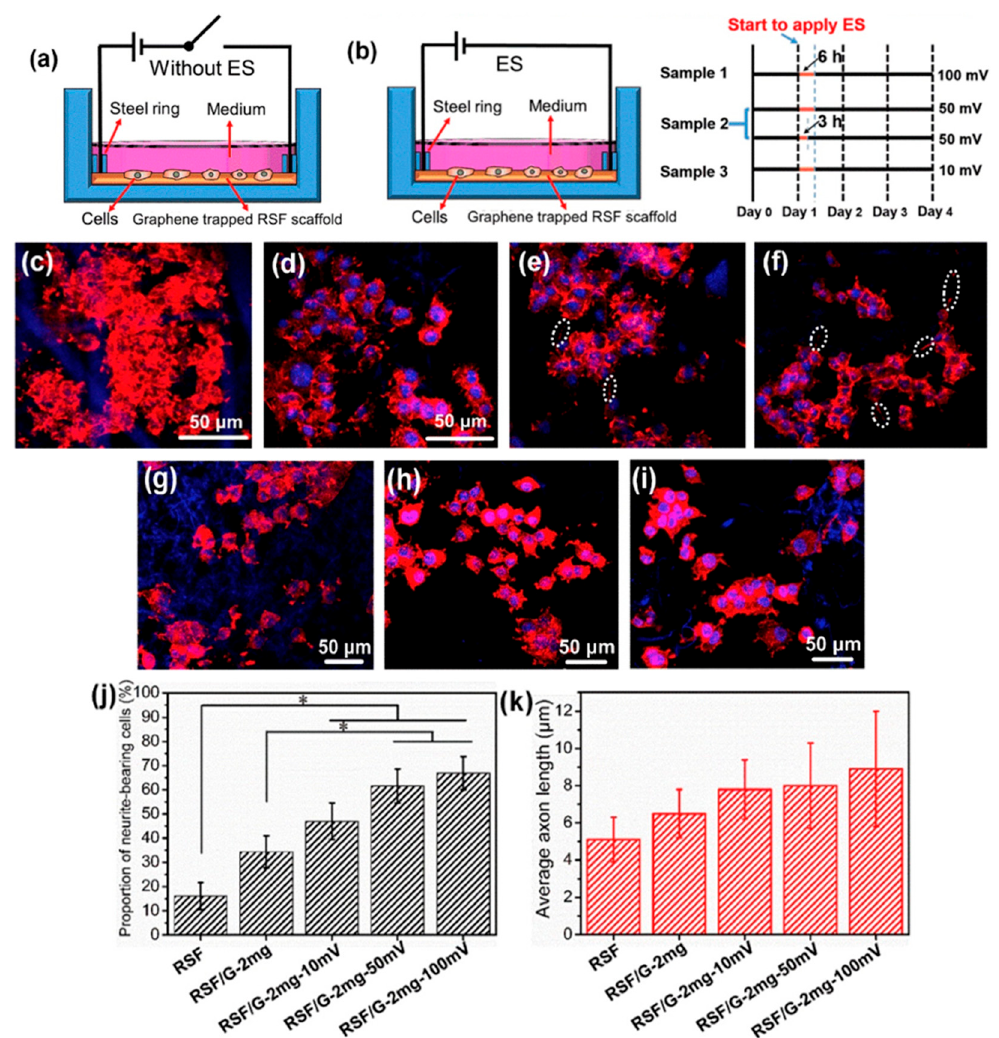
Figure 6. ( a , b ) Schematic representation of the cell culture device ( a ) without electrical stimulation (ES) and ( b ) with ES. The right-hand side of ( b ) shows the ES experimental design, where black lines indicate periods without ES, and yellow lines indicate periods with ES. ( c – f ) Representative laser scanning confocal microscope images of PC12 cells cultured on ( c ) regenerated silk fibroin (RSF), (d) RSF/G-1mg, (e) RSF/G-2mg and ( f ) RSF/G-4mg for four days, without ES (white ellipses indicate axons). ( g – j ) Laser scanning confocal microscope images of PC12 cells cultured on RSF/G-2mg scaffolds for four days with voltages of ( g ) 10 mV, (h) 50 mV and (i) 100 mV. ( j ) The proportion of PC12 neurite-bearing cells. ( k ) Average axon length of PC12 cells with and without ES (* P < 0.05). ( g – k ) ES time is 6 h [107]. Reproduced with permission from Zhang et al., Carbon , published by Elsevier, 2019.